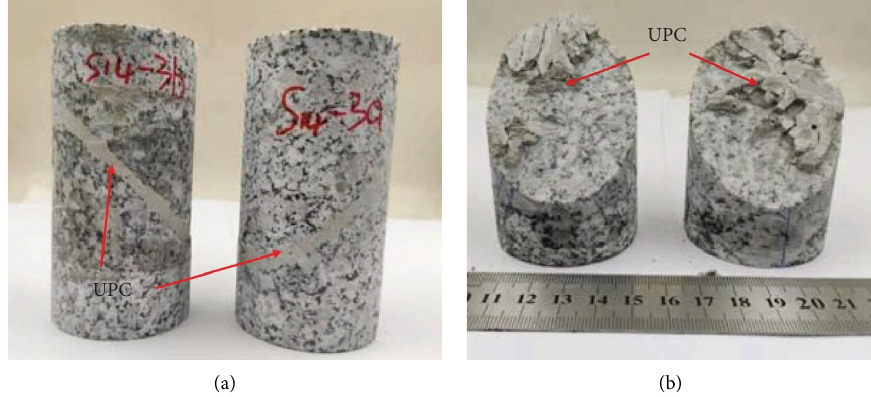
Figure 29: Before damage (a) after damage and (b) of the sample at day 14 with a 3 mm cement repair